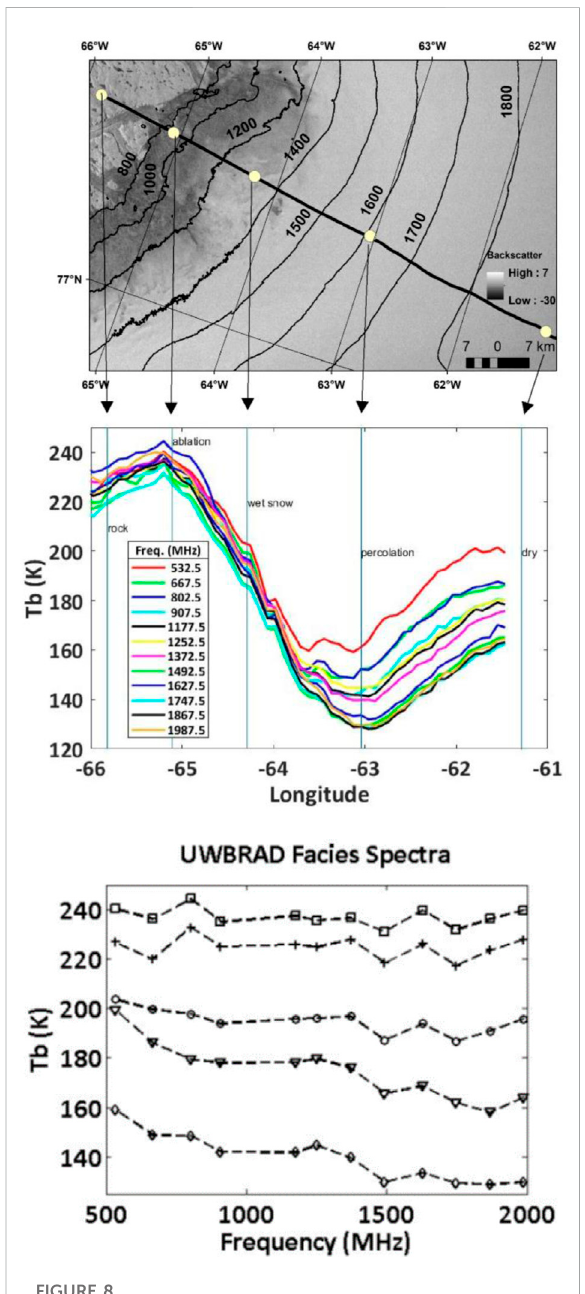
FIGURE 8 (Top) Segment of the 2016 UWBRAD fl ight line (thick black line)andsurfaceelevationcontoursinmeters(irregularblacklines) overlaid on an 27 August 2016 ALOS-2 PALSAR-2 L-band radar image. White circlesindicatetheapproximatecenter ofsnow facies along the path. (Left to right) Terrain types are snow- covered rockandlaketerrain,ablation,wet snow,percolation,and dry snow (Middle) UWBRAD 12-channel data indicating the locationofsnowfacies.Thelegendidenti fi esthecenterfrequency in megahertz of each channel. (Lower) Individual facies spectra: deglaciated terrain consisting of bare rock and small lakes (plus), ablation(square),wetsnow(circle),percolation(diamond),anddry snow transition (triangle). The locations of the data are identi fi ed by white circles in the upper map fi gure (From Jezek et al.,